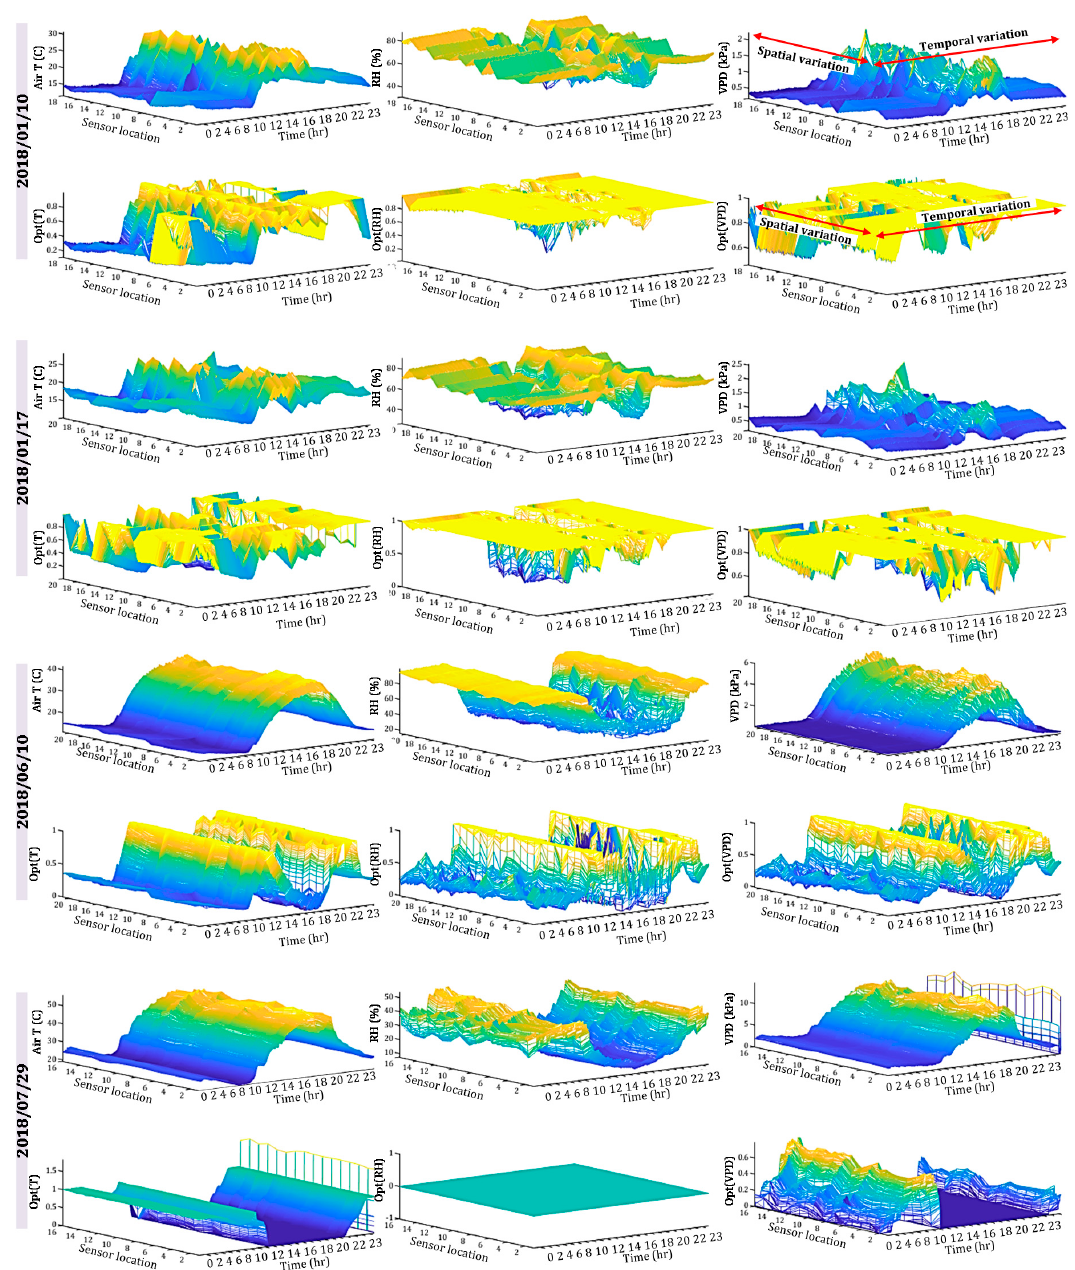
Figure 12. Temporal and spatial changes of temperature, relative humidity and vapor pressure deficit (VPD) and their corresponding optimality degrees in the measured points inside the greenhouse.